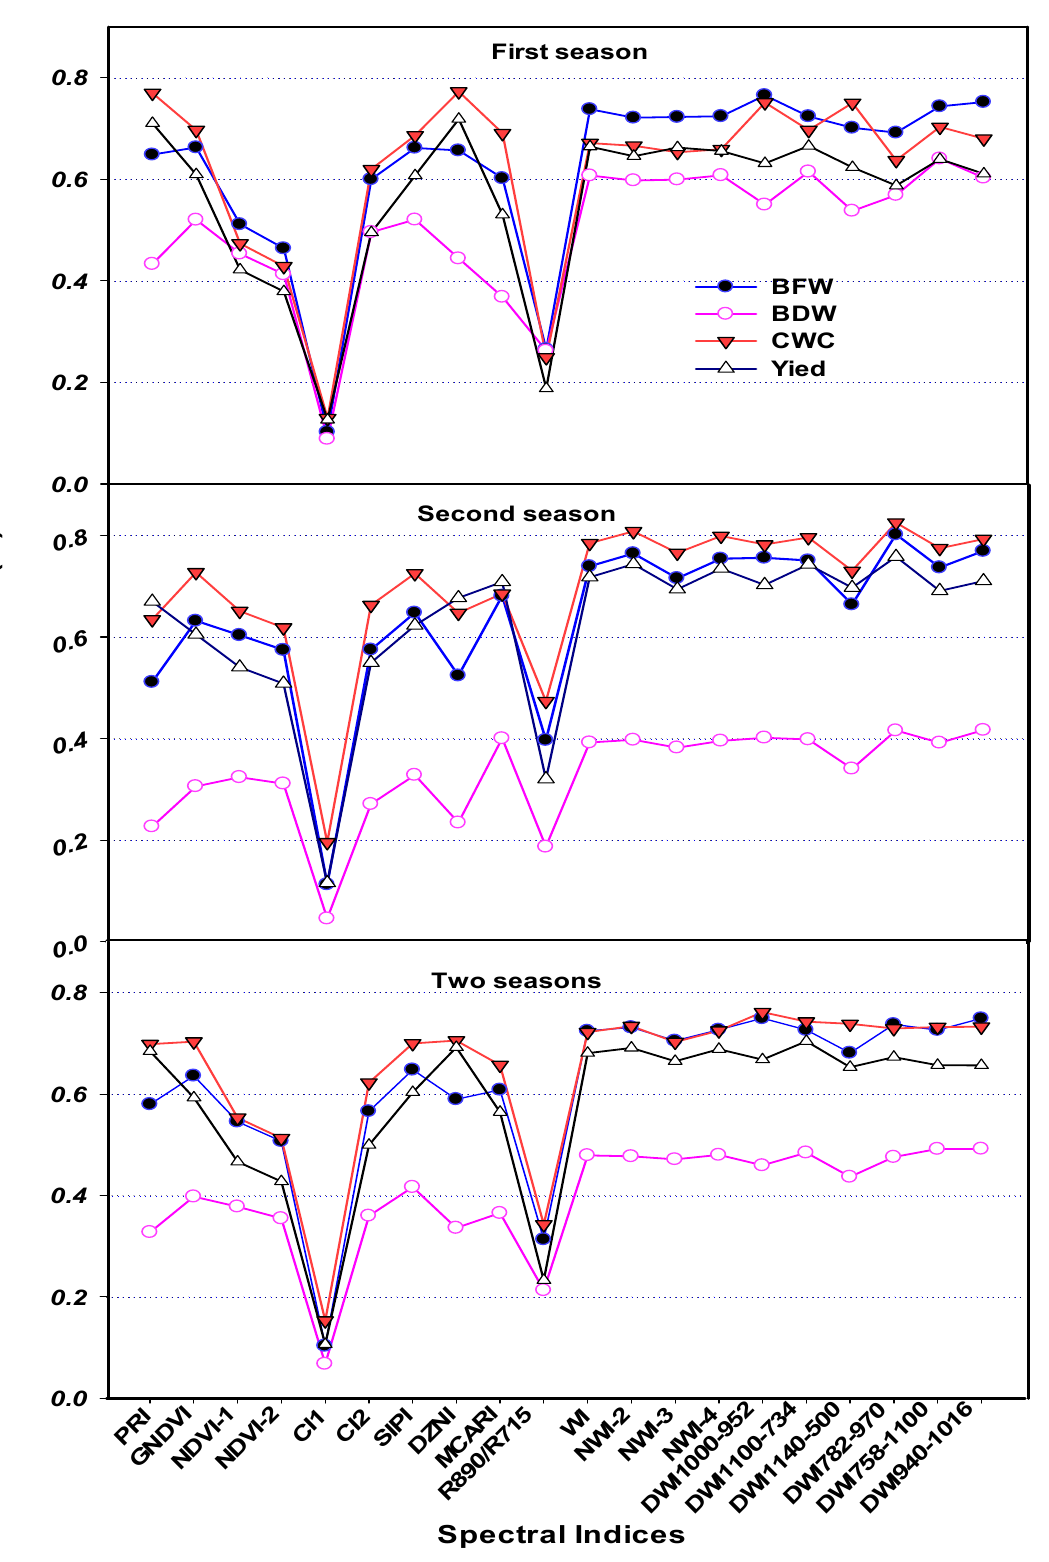
Figure 5. Coefficients of determination (R 2 ) for the relationship between selected SRIs and biomass fresh weight (BFW), biomass dry weight (BDW) canopy water content (CWC) and total tuber yield (TTY) for each season ( n = 24) and across two seasons ( n = 48).